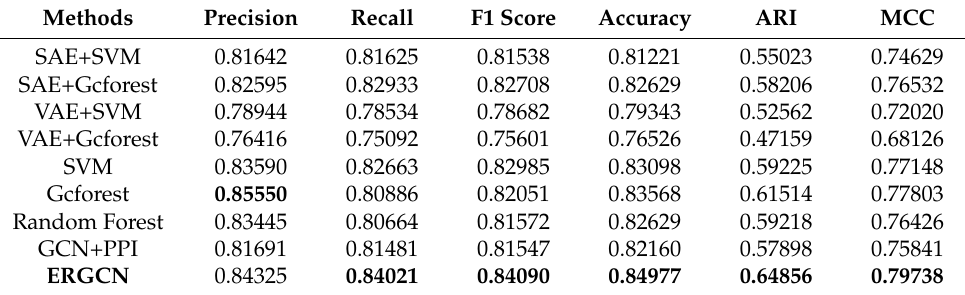
Table 6. The experiment results for a new sample on GBM dataset.